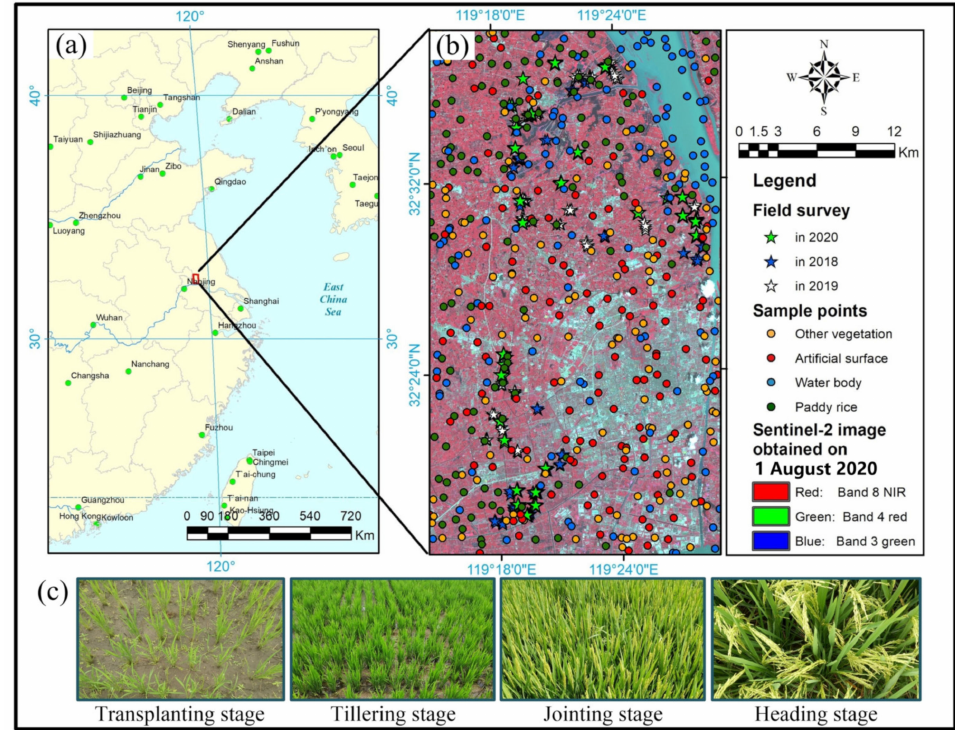
Figure 1. Geographical location of the study area, field survey and sample points. ( a ) Location of the study area; ( b ) field survey and sample points in the study area; ( c ) four key growth stages of rice in the study area.